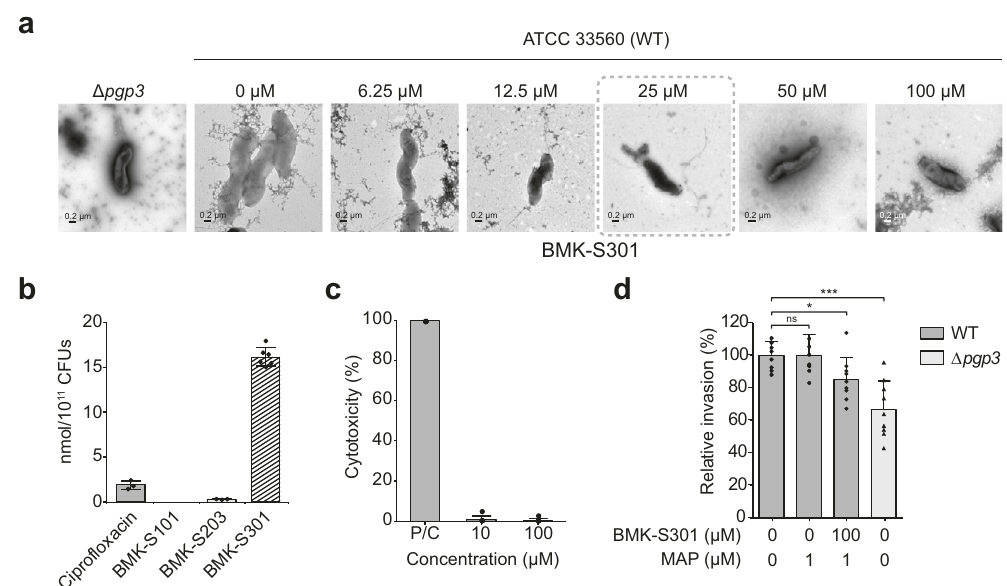
Fig. 5 Cell morphology change, cell penetration, and invasion assays in cultured C. jejuni cells. a TEM analysis of C. jejuni strains upon BMK-S301 treatment. C. jejuni ATCC 33560 WT was negatively stained with 2% (w/v) uranyl acetate and then observed by using TEM. For inhibitor-treated sample, each concentration of inhibitor was incubated in 37 °C for 24 h before staining. Scale bars (lower left) represent 0.2 μ m. The minimum concentration of inhibitors which shows changes in the cell morphology is highlighted in gray dashed box. b Accumulation of Pgp3 inhibitors in C. jejuni cells. The BMK-S203 and S301 that are active against C. jejuni than BMK-S101 exhibit accumulation in the bacteria. BMK-S301 is the most permeable compound through the outer membrane of C. jejuni . Cipro fl oxacin was used as a reference compound for the accumulation assay (P/C, positive control). c The cytotoxicity of BMK-S301 for Caco-2 epithelial cells. Cytotoxicity was determined using LDH activities released from Caco-2 epithelial cells treated with the 10 or 100 μ M BMK-S301 for 3 h. Cells were lysed with 2% Triton X-100 for 15 min to release all LDH to 100%. d The effect of BMK-S301 on the host cell invasion. 100 μ M BMK-S301 with 1 μ M MAP (membrane-active peptide, KL-L9P) was used for invasion assay. Caco-2 epithelial cells were with C. jejuni ATCC 33560 WT and the numbers of intracellular bacteria were determined 3 h after infection using the gentamicin-protection assay. Error bars represent the means and SEM from three independent experiments. The asterisk shows statistical signi fi cance (* p < 0.05; *** p < 0.001; ns not signi fi cant). The source data is provided in Supplementary Data